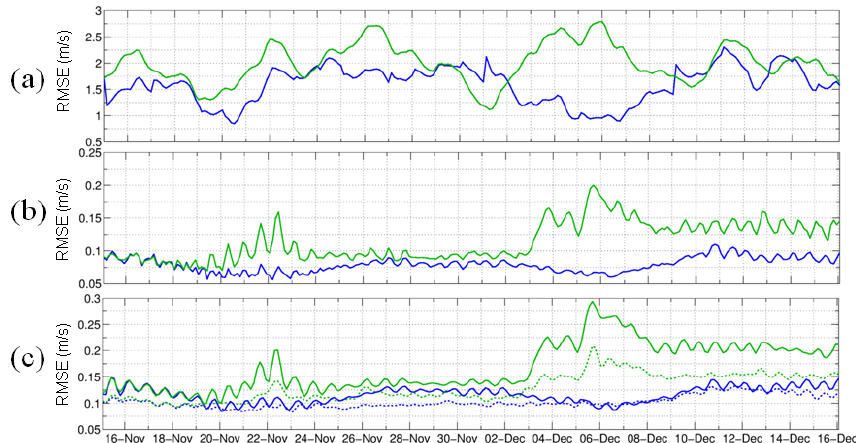
Figure 4. Root mean square error Er time evolution of (a) wind ( W ) , (b) radial velocity ( y ) and (c) surface current ( U ) for WindTE , computed over the POD (full lines) or the MD (dashed lines). Er b (Er a ) is in green